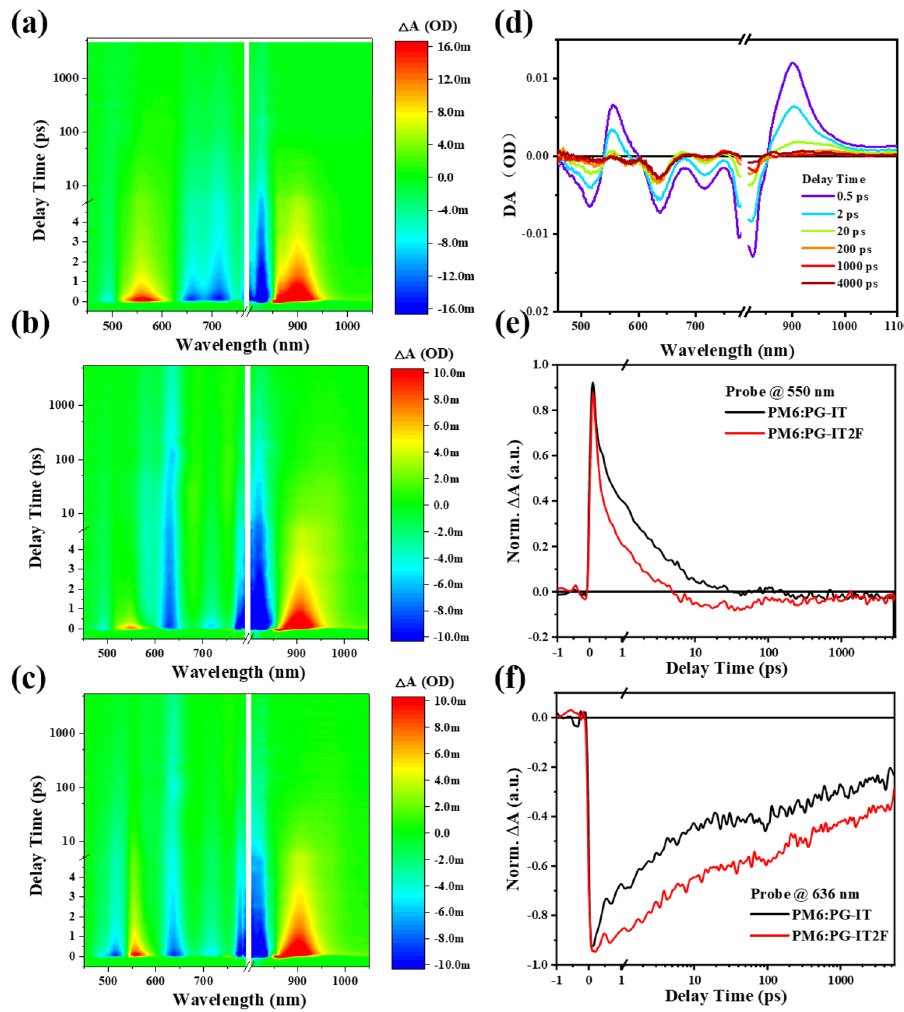
Fig. 3 | Femtosecond transient absorption kinetics. a PG-IT pristine fi lm, b PM6:PG-IT blend fi lm, and c PG-IT2F blend fi lm with excitation at 840nm. d Transient spectra of PM6:PG-IT blend at selective delay times. Transient kinetic